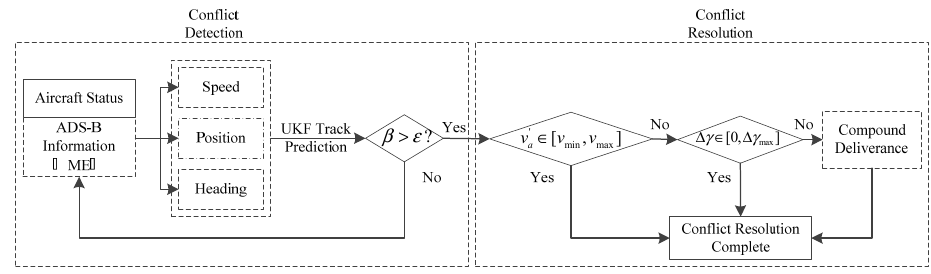
Figure 7. UAV con fl ict resolution process. Figure 7. UAV conflict resolution